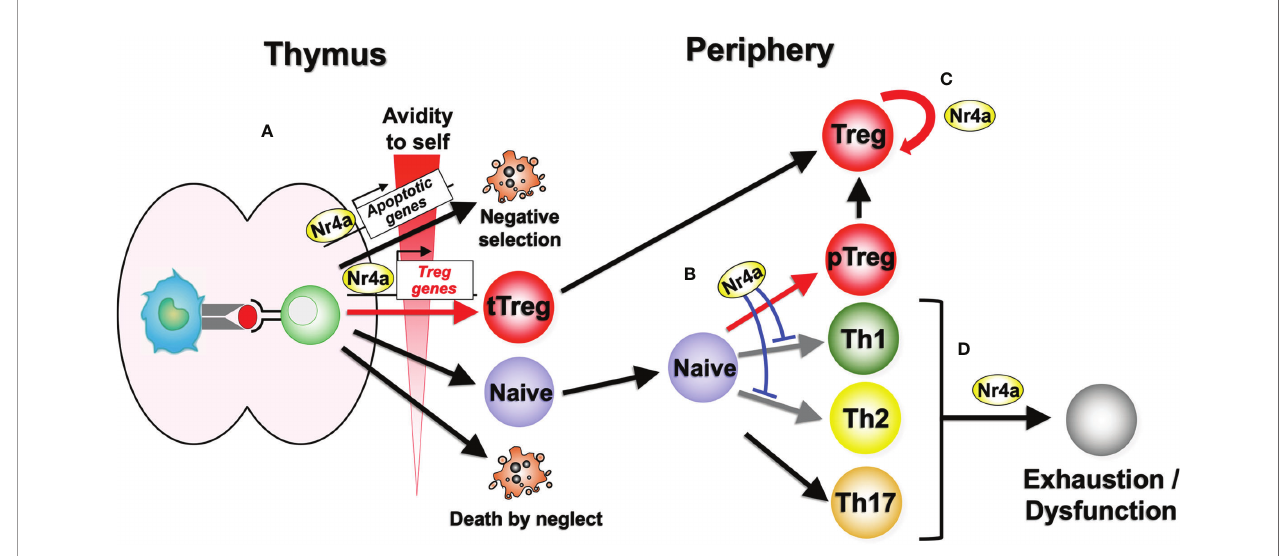
FIGURE 1 | Nr4a factor functions in lymphoid Treg cell differentiation and maintenance. (A) Nr4a factors function as effectors in thymocyte fate decisions according to the avidity for self antigens. Strong avidity to self antigens induces higher amount of Nr4a factors which promotes apoptosis or Treg cell differentiation. “ Death by neglect ” represents the event of cell death that happen to thymocytes that could not recognize peptide-loaded self-MHC molecules during positive selection. (B) In the periphery, Nr4a factors promote Treg cell differentiation from naive T cells, while repressing Th1 and Th2 cell differentiation. Regulation of Th17 cells by Nr4a factors are still in debate. (C) Nr4a factors maintain the lineage stability of Treg cells. (D) Nr4a factors promote effector T cell exhaustion and/or